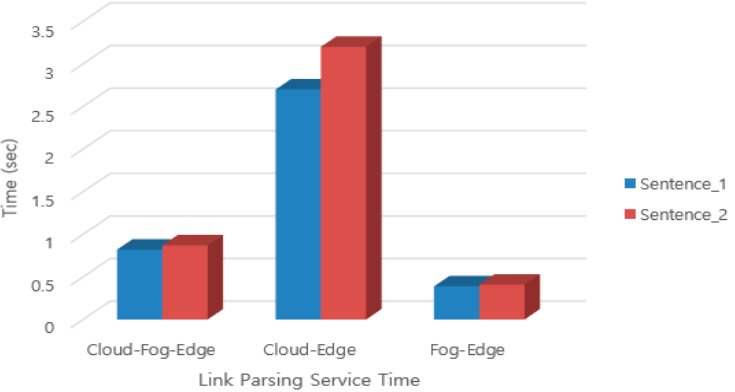
Figure 11. Link parser service time according to the fog service model.